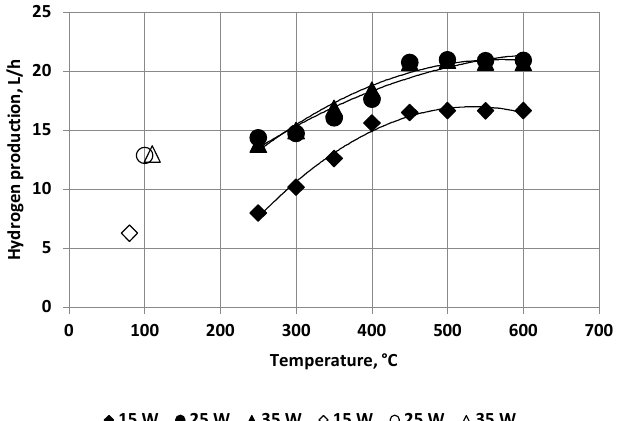
Figure 1. The ethanol conversion (markers with background relate to a process in which the catalyst was not heated).